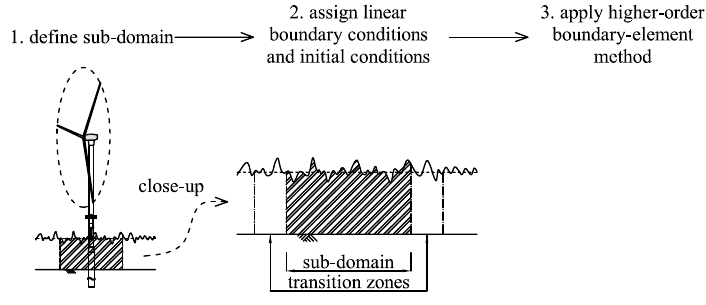
Figure 11. Schematization of the sub-domain analysis approach of non-linear irregular waves [82].